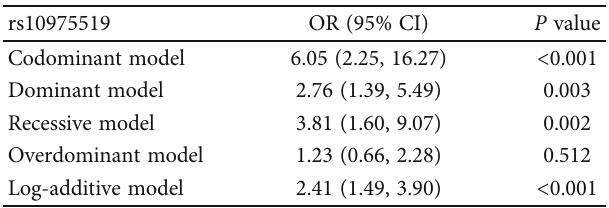
Table 4: Multiple inheritance analysis of rs10975519 with the adjustment of sirolimus